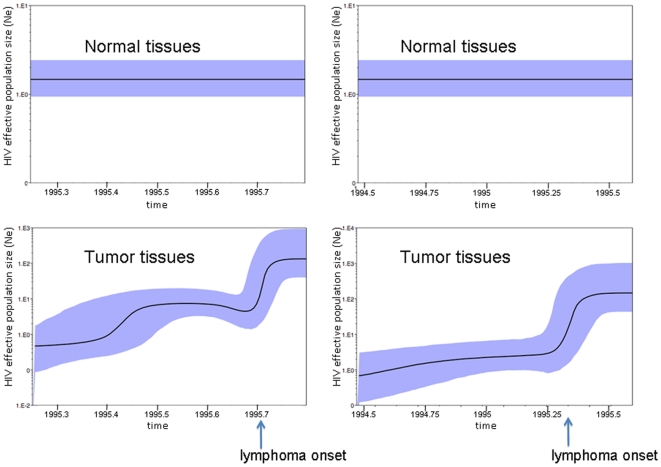
HIV-1 population dynamics in tumor and non-tumor tissues.Bayesian estimates of HIV-1 effective population size (number of infectious genomes effectively contributing to the next generation, y-axis) over time (x-axis) were inferred using the models that fitted best for each data set according to the Bayes Factors test (see Supplemental Table S2). The black line represents the median estimate of the effective population size with the shaded area showing the 95% high posterior density intervals of the estimates. Top panels. Constant population size over time of HIV-1 in normal tissues from patient AM (left panel) and IV (right panel). Bottom panels. Non-parametric estimates (Bayesian skyline plots) of effective population size change over time for subject AM (left panel) and IV (right panel).